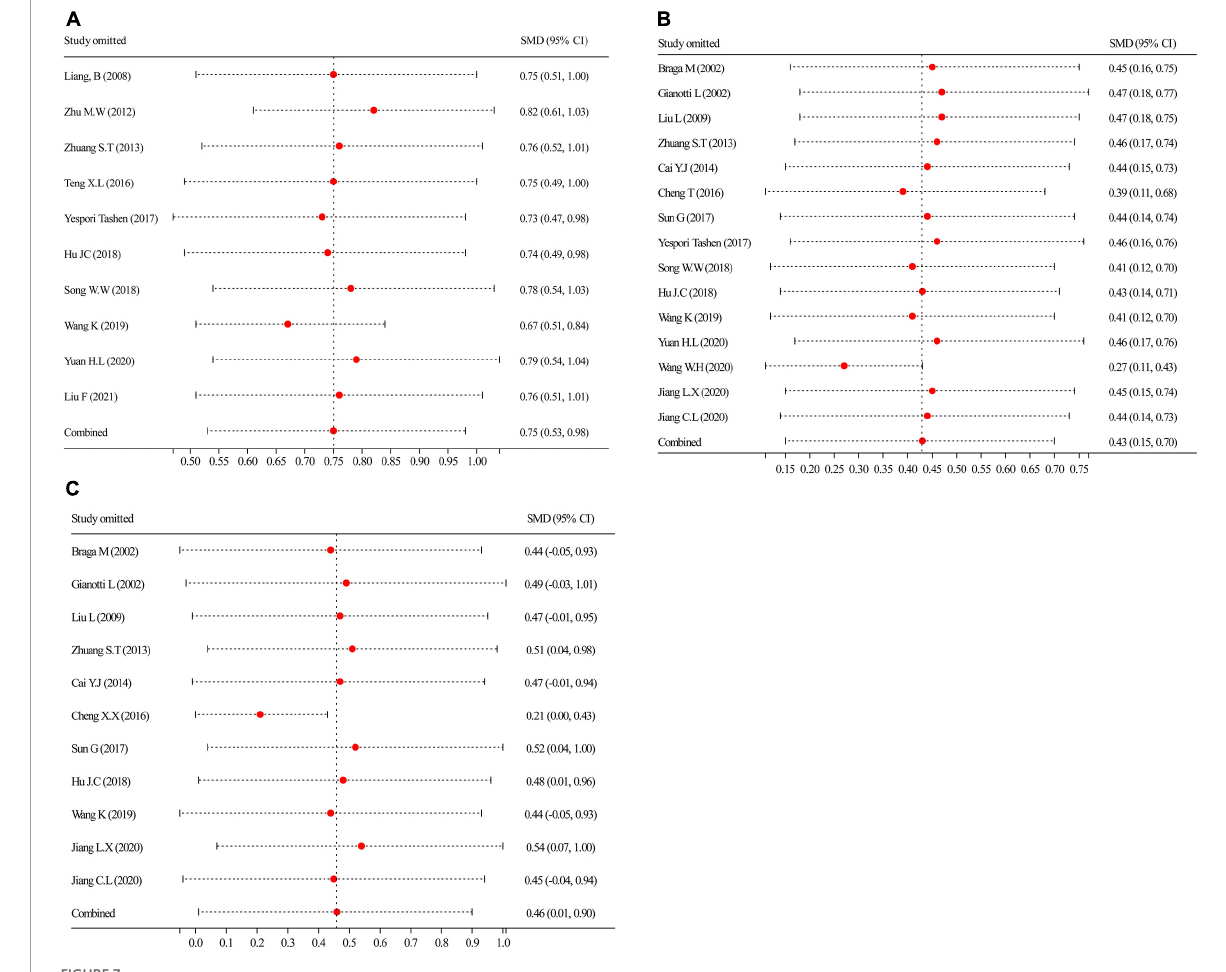
FIGURE7 By leaving a procedure, each time was performed to carry out sensitivity analyses. (A) Sensitivity analysis of CD4 + ; (B) sensitivity analysis of ALB; and (C) sensitivity analysis of PA. ALB, albumin; PA,